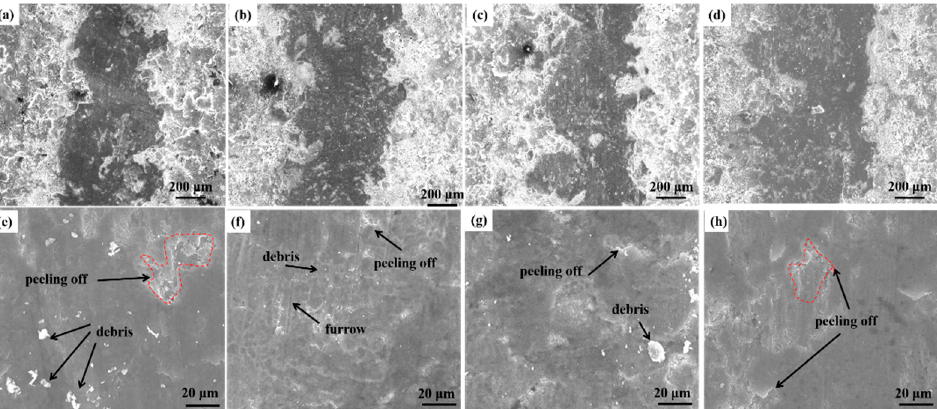
Figure 12. Wear scars of FeCoNiCrMo 0.2 high entropy alloy coating sprayed by plasma at different currents under 25 N load after shot peening treatment ( a , e ) 250 A, ( b , f ) 350 A, ( c , g ) 450 A, ( d , h ) 550 A.